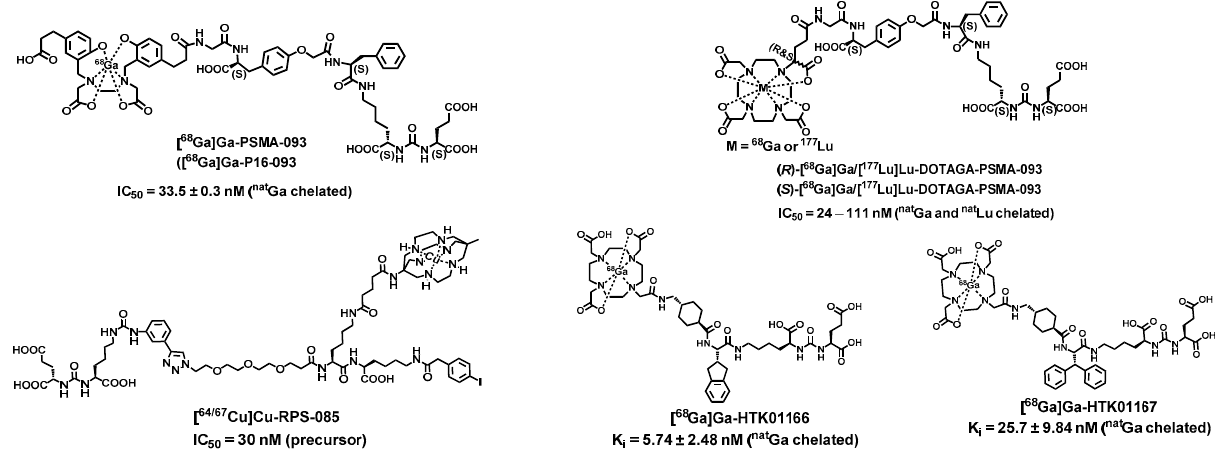
Figure 3. Representative radiometal-based PSMA targeting agents